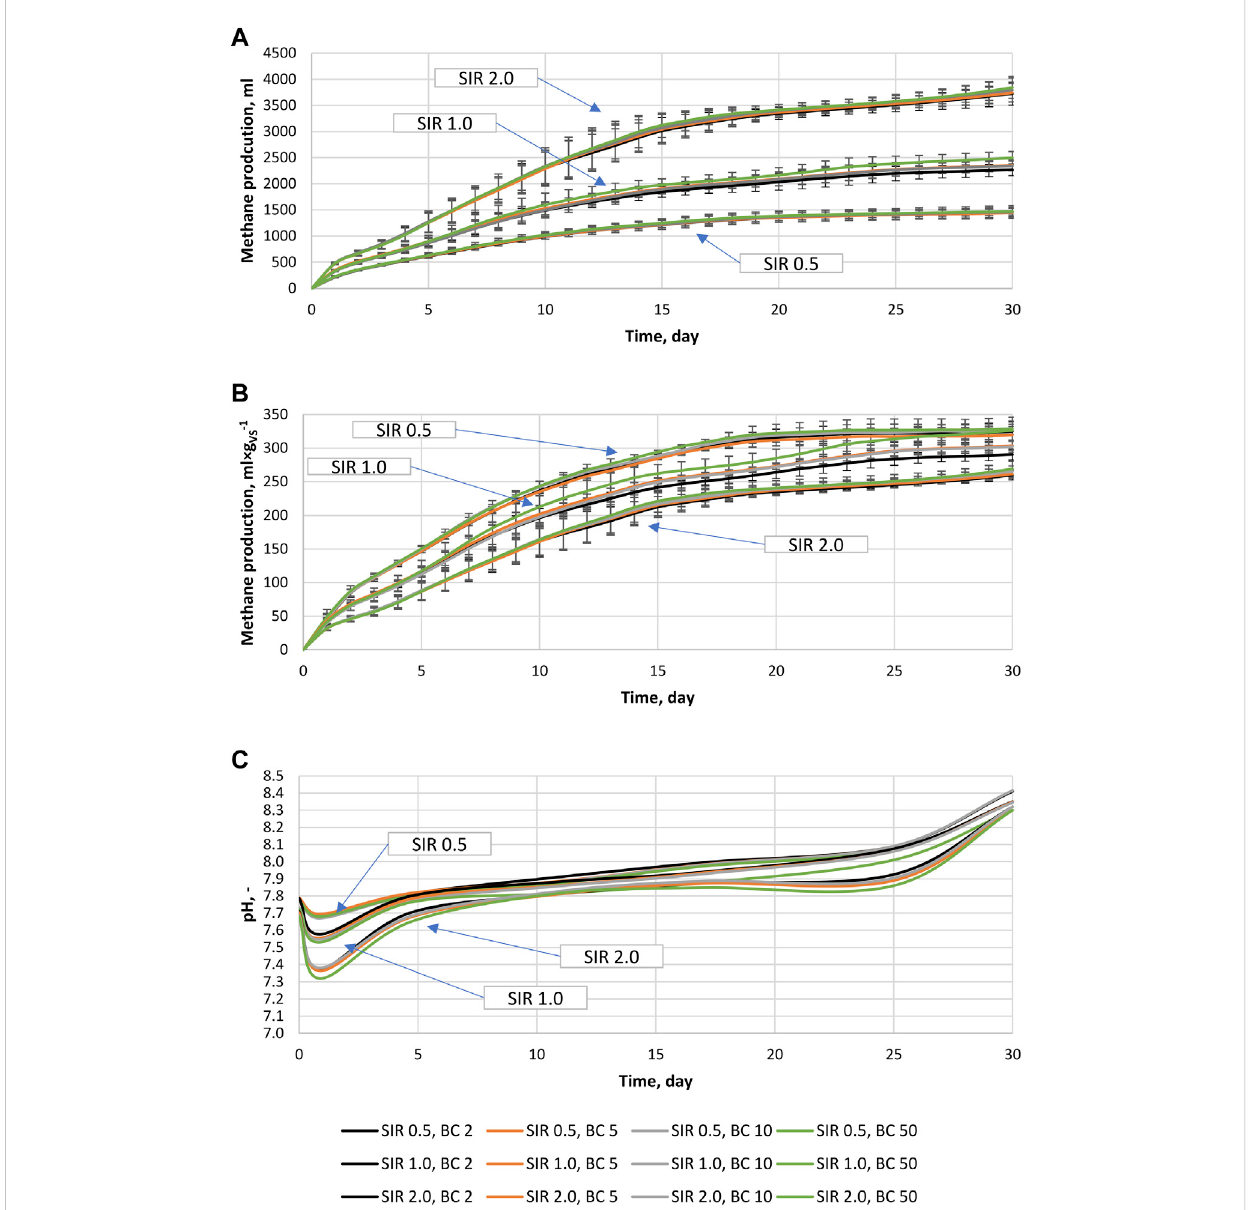
Frontiers in Energy